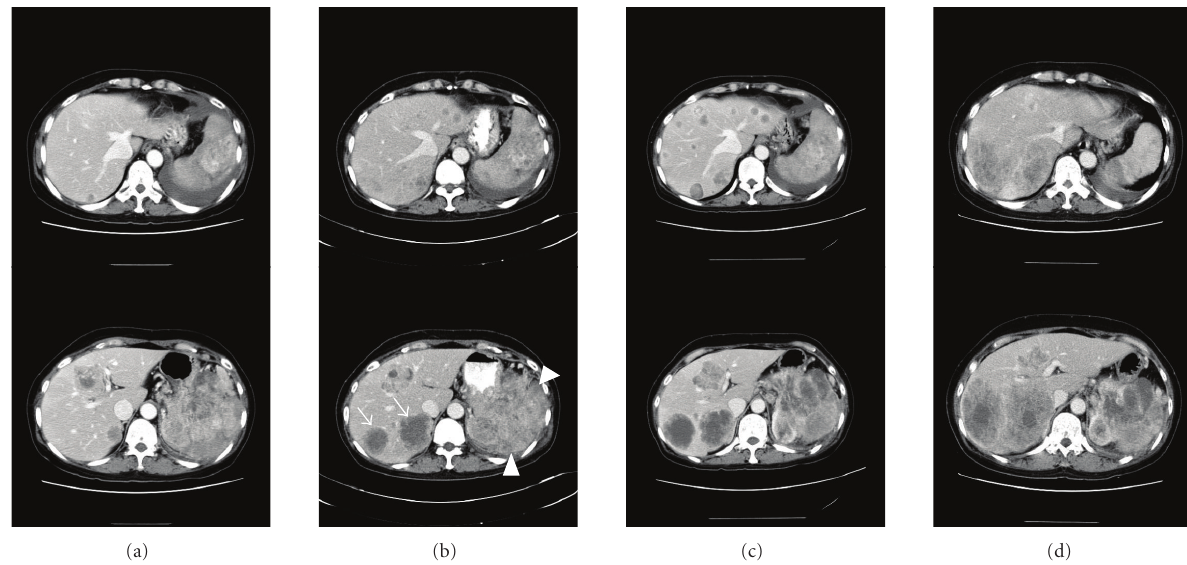
Figure 1: Serial CT scans show variable response in retroperitoneal mass (arrowhead), multiple nodules of left hepatic lobe and two nodules (arrows) of right posterior lobe. (a) At initial presentation, (b) after one cycle of weekly paclitaxel, (c) after two cycles of doxorubicin, (d) after 3 months of